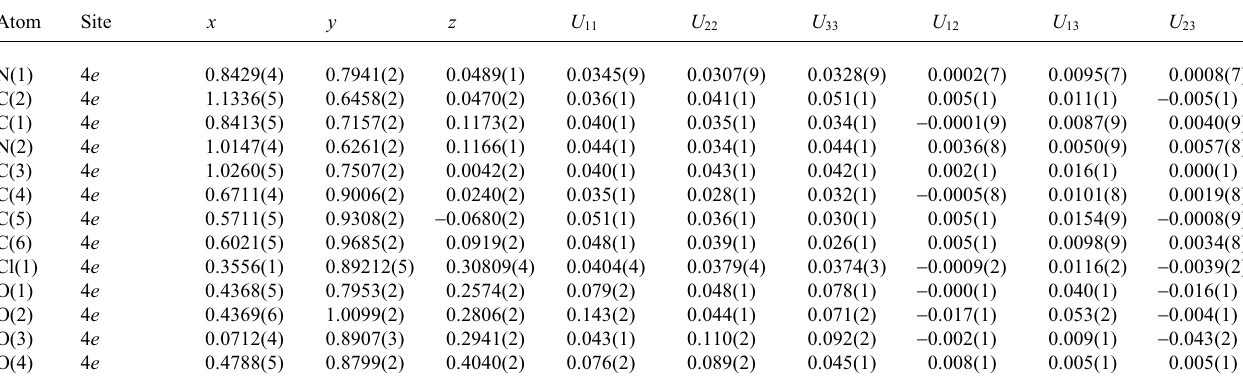
Table 3. Atomic coordinates and displacement parameters (in Å 2